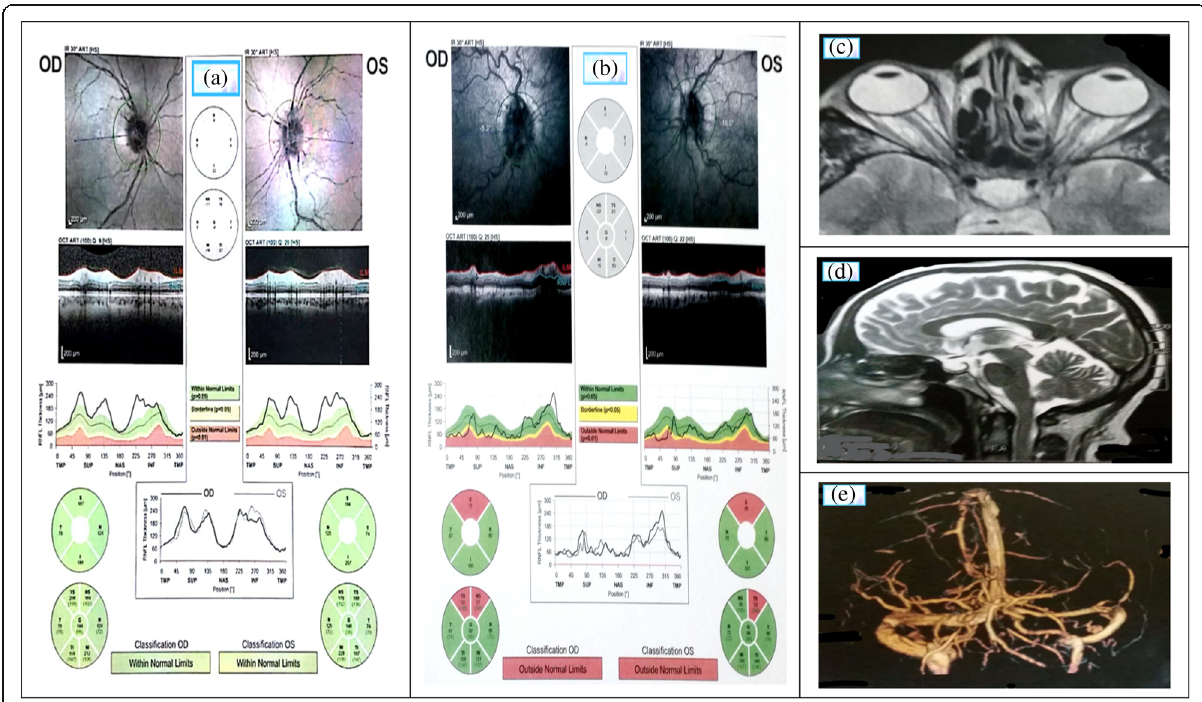
Fig. 1 Optical coherence tomography (OCT) and brain MRI/MRV of IIH cases showing a increased thickness of OCT – RNFL due to papilledema, b decreased superior RNFL thickness due to axonal loss after 6 months of medical treatments, and c – e brain MRI/MRV of IIH patient showing tortuous optic nerves with dilated subarachnoid spaces, empty Sella turcica, and attenuated left transverse